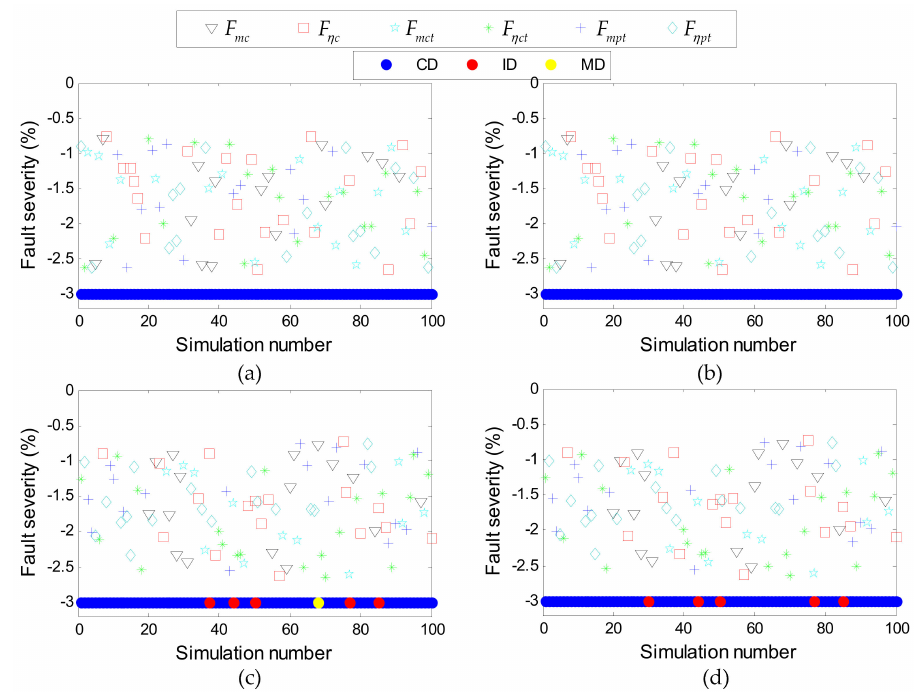
Figure 12. The type and amplitude of multiple faults and the corresponding FDI results of 100 stochastic simulations. ( a ) The type and amplitude of the first abrupt fault and corresponding FDI results; ( b ) The type and amplitude of the first gradual fault and corresponding FDI results; ( c ) The type and amplitude of the second abrupt fault and corresponding FDI results; ( d ) The type and amplitude of the second gradual fault and corresponding FDI results. Table 7. The FDI results of 100 stochastic simulations in the scenarios of multiple faults. FDI Fault Change Faults Simulation Times